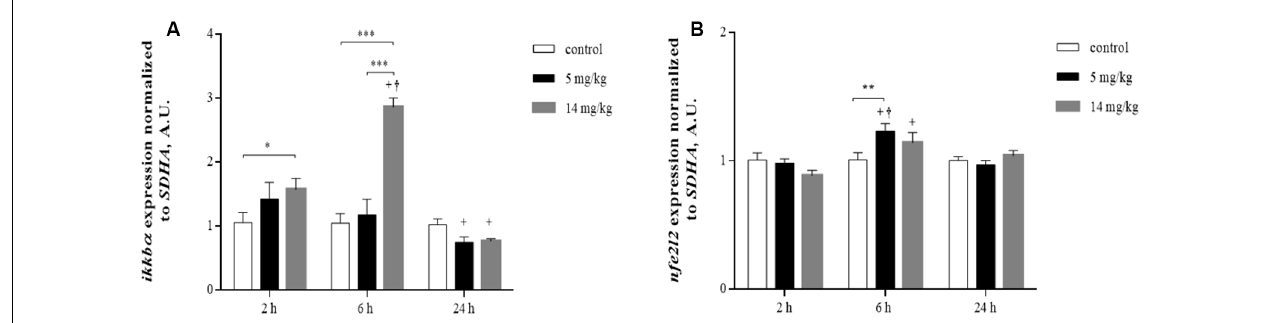
FIGURE 5 | Inorganic arsenic (iAs) effects on the messenger RNA (mRNA) levels of ikkb α (A) and nfe2l2 (B) in the cortex of mice treated with 0, 5, or 14 mg/kg NaAsO 2 . For real-time PCR, total RNA was extracted from the brain cortex as described in “Materials and Methods” section. The data were normalized to the SDHA mRNA expression. The vertical bars indicate the mRNA levels relative to the control group. The bars represent the mean ± SE ( n = 7). Different superscript symbols above each column indicate statistically significant differences; ∗ P ≤ 0.05, ∗∗ P ≤ 0.01, ∗∗∗ P < 0.001. Plus symbol denotes differences from the 2 h group, dagger symbol denotes differences from the 24 h group, two-way ANOVA with Tukey’s post hoc analysis. Significance was accepted at P ≤ 0.05.